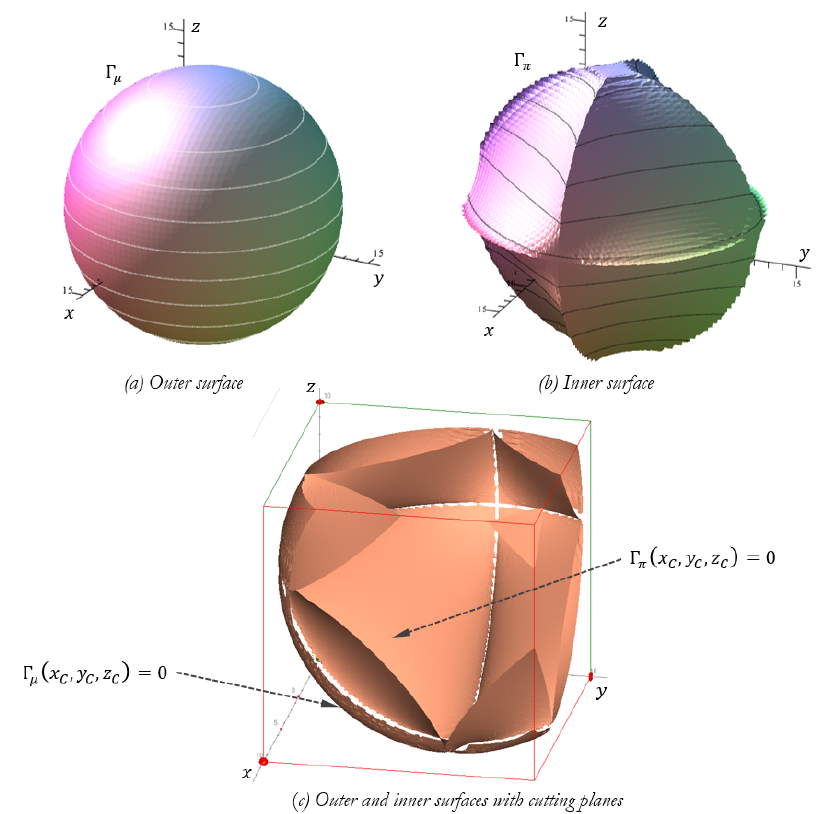
Figure 14. Direct singularity locus in the workspace for the real